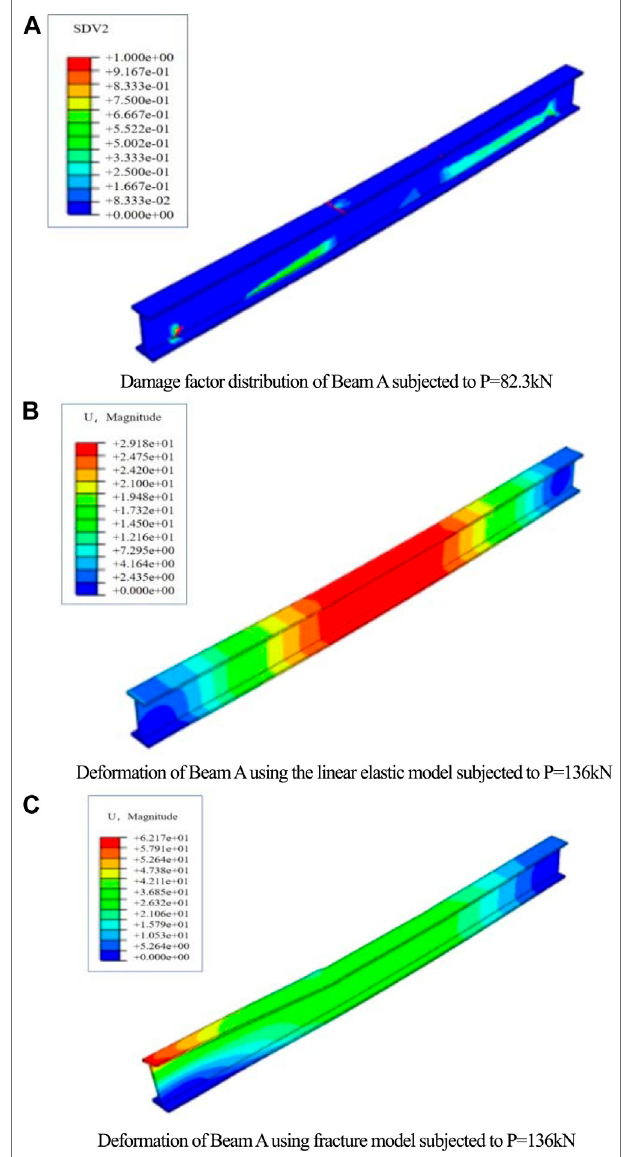
FIGURE4| DamageanddeformationsimulationsofBeamA,whereUis the vertical displacement of the element. (A) Damage factor distribution of Beam A subjected to p = 82.3 kN. (B) Deformation of Beam A using the linear elasticmodelsubjectedto p =136 kN. (C) DeformationofBeam Ausing the fracture model subjected to p = 136 kN.